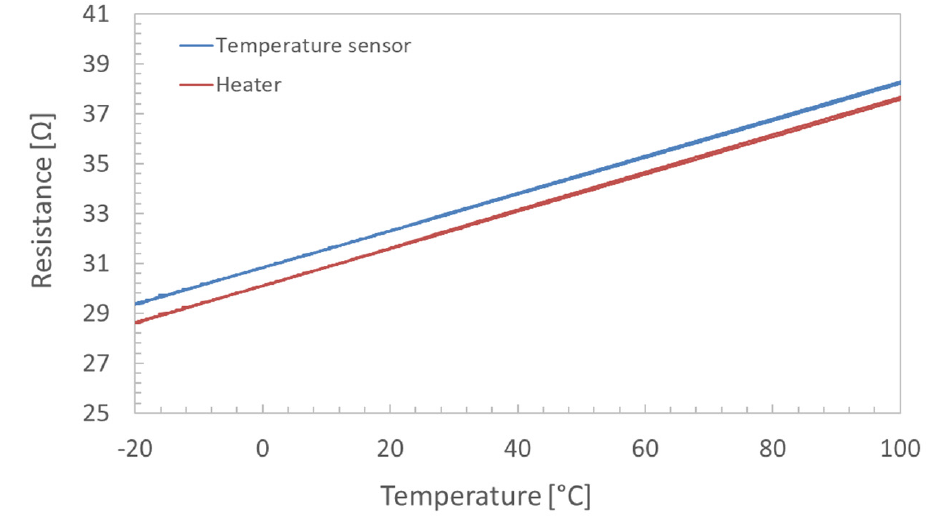
Figure 1. Calibration of the deposited resistors on the QCM in a thermal bath.